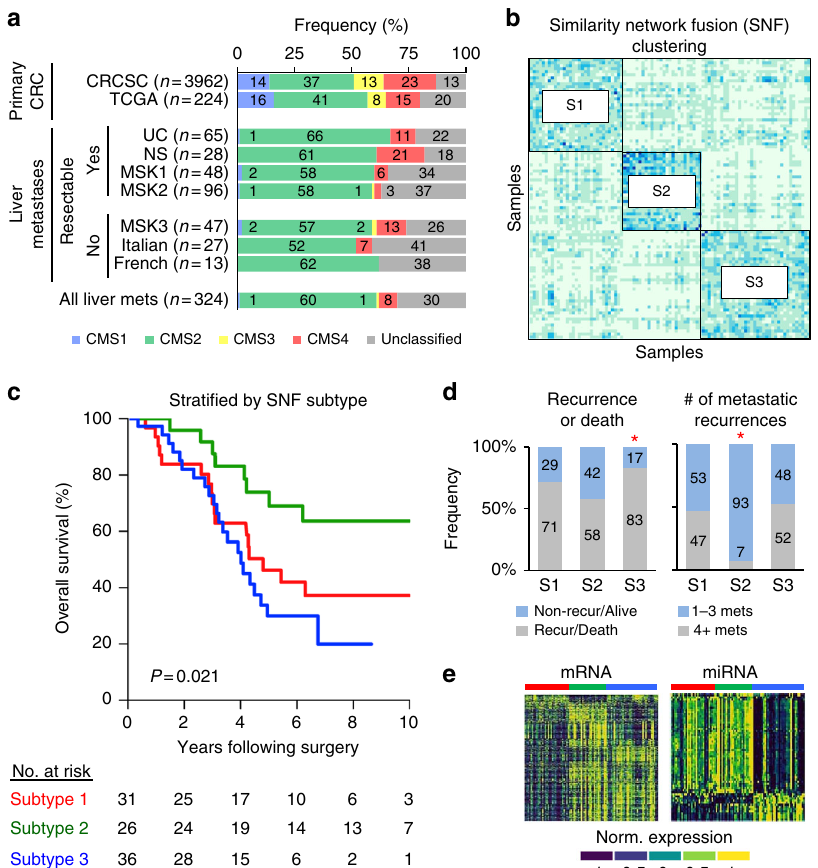
Fig. 2 Identi fi cation of intrinsic molecular subtypes of colorectal liver metastases. a Consensus molecular subtypes (CMS) of primary colorectal cancers obtained from the Colorectal Cancer Subtyping Consortium (CRCSC) or calculated in primary colorectal cancers of The Cancer Genome Atlas (TCGA). CMS subtypes were also determined in colorectal liver metastases from patients undergoing partial hepatectomy of resectable liver metastases (UC, NS, MSK1, and MSK2 cohorts) or biopsy of unresectable liver metastases (MSK3, Italian and French cohorts). Cohorts contain independent clinical and molecular datasets (see Supplementary Information). b Consensus clustering based on similarity network fusion (SNF) subtyping of colorectal liver metastases. Subtype 1 = S1, Subtype 2 = S2, Subtype 3 = S3. c Kaplan – Meier curves of overall survival by molecular subtype. P -value was determined using a log-rank test. d Metastatic recurrence patterns by molecular subtype. Asterisks denote statistical signi fi cance based on Fisher ’ s exact test for each subtype versus the two other subtypes. e Differentially expressed mRNAs (left) and miRNAs (right) between the three molecular subtypes